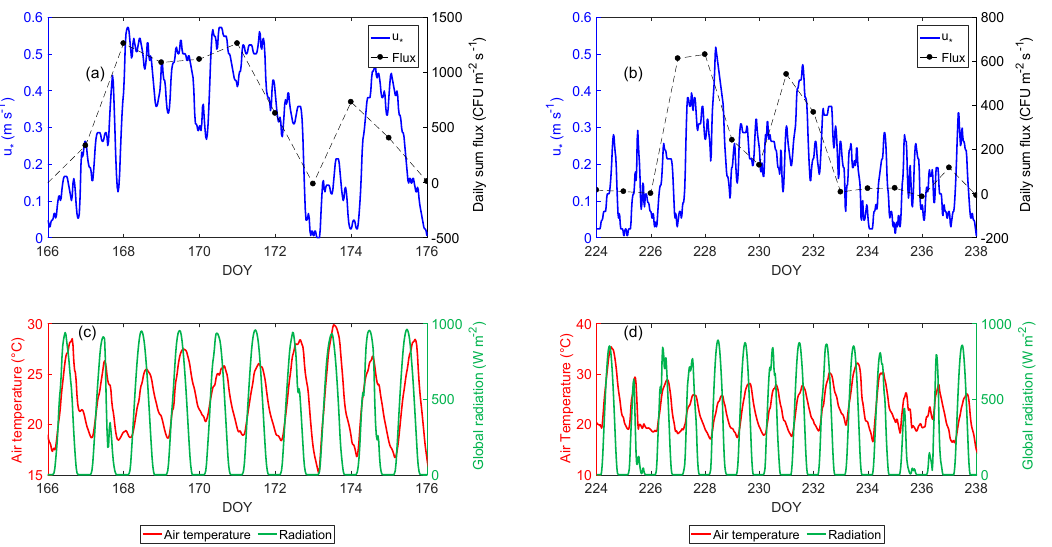
Figure 10. High wind events in 2015 in Montfavet, France. Plots (a) and (b) show friction velocity (left y axis) and the daily sum of flux (right y axis) for two high wind events (DOY 166–176 and 224–238 of 2015). Plots (c) and (d) show solar radiation (right y axis) and air temperature (left y axis) for the same two